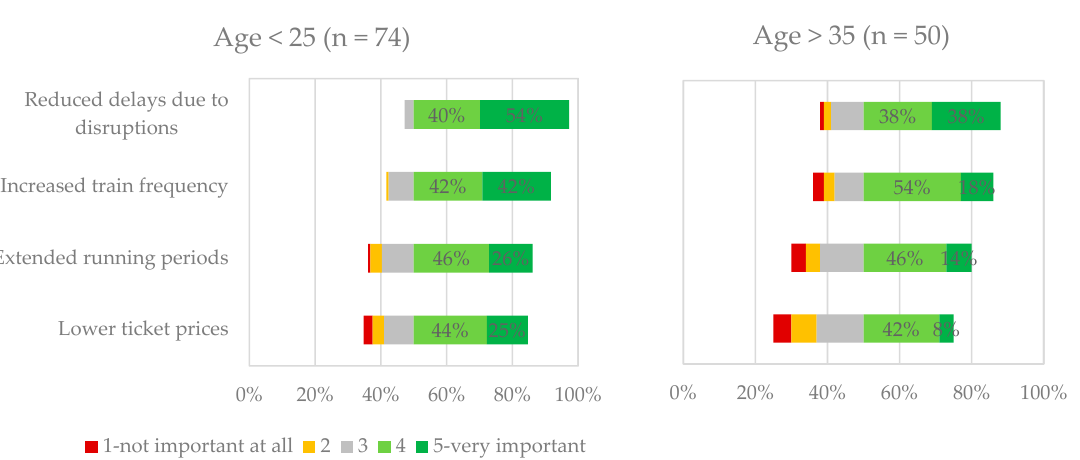
Figure 6. Importance of the Operational Aspects of Teleoperation per age.